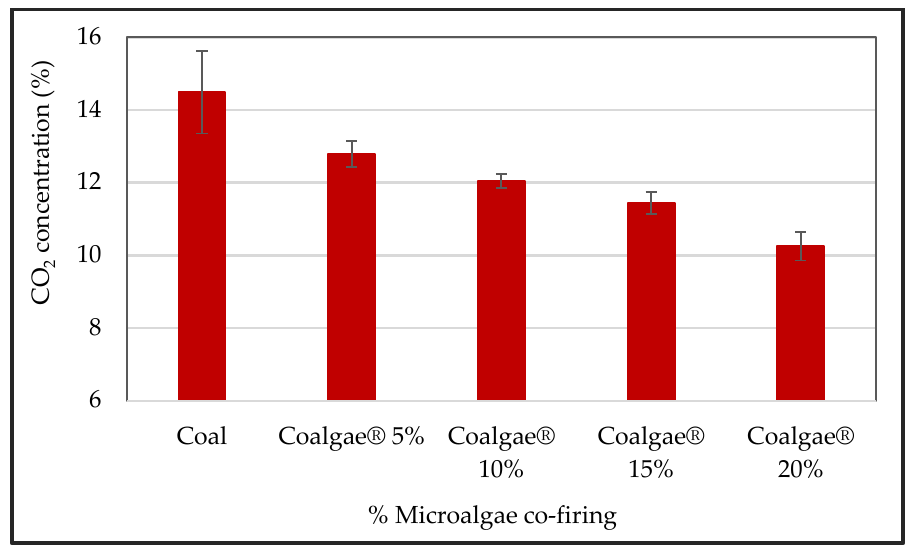
Figure 6. Average concentration of CO 2 in flue gas.